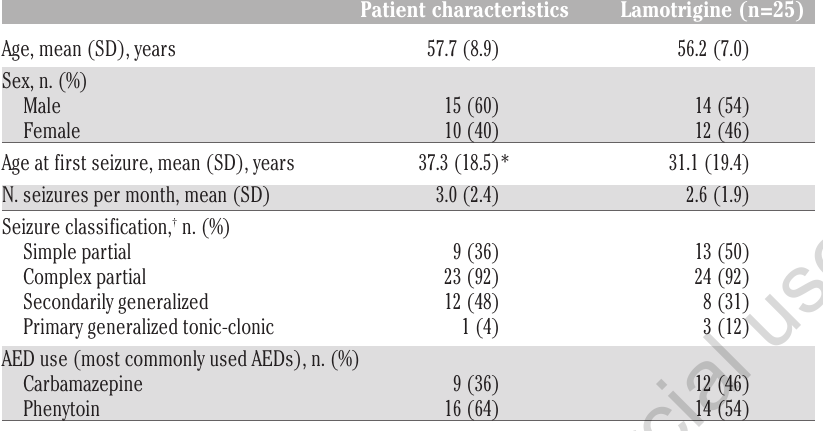
Table 2. Baseline demographics and characteristics.